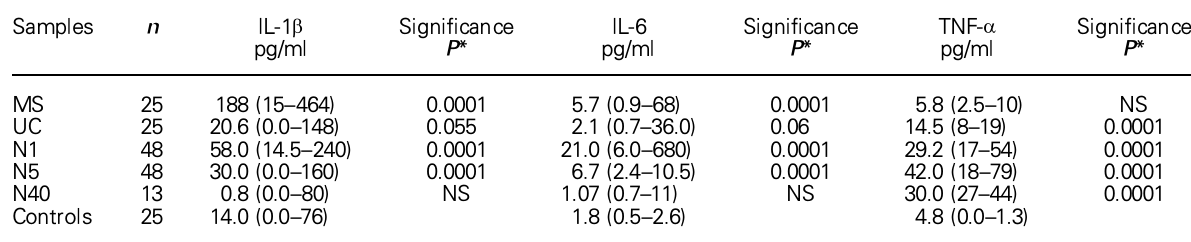
Table 2. Cytokine values (median, range) in maternal serum (MS), umbilical cord (UC) and newborn infant serum, in the 1st (N1), 5th (N5) and 40th (N40) days after birth and in adult controls